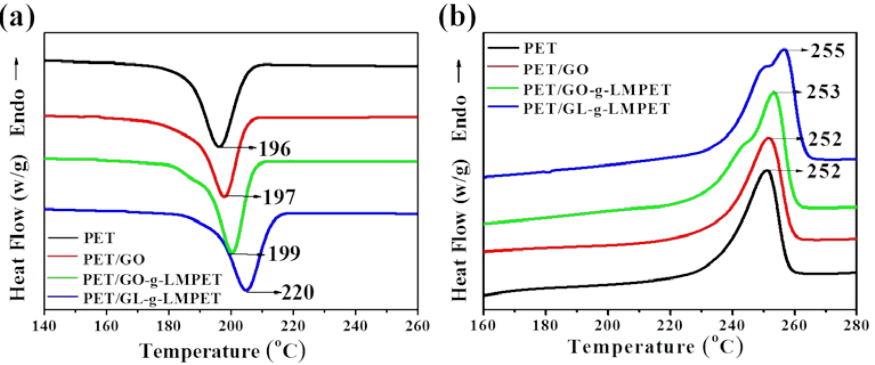
Figure 7. The heating curve ( a ) and the cooling curve ( b ) of pure PET, PET/GO, PET/GO- g -LMPET and PET/GL- g -LMPET at the rate of 10 °C·min −1 . Table 2. Thermo-performance parameters and the degree of crystallinity of various nanocomposites. Sample (0.5 wt %)